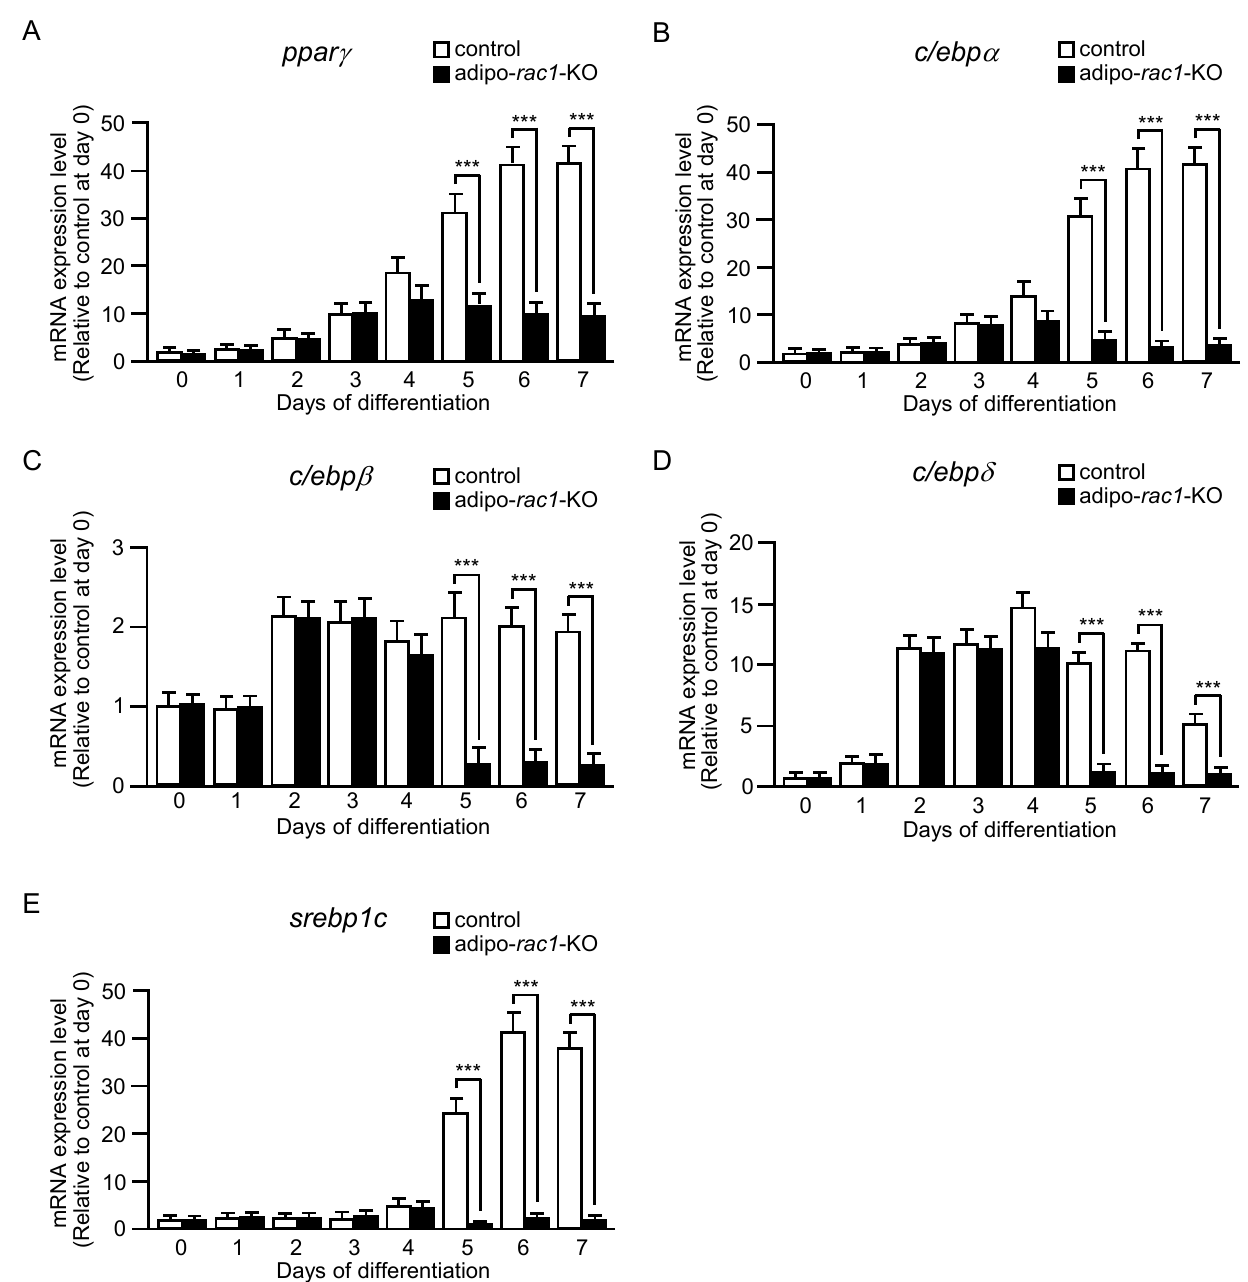
Figure 3. The expression of transcription factors during differentiation of adipose progenitor cells into adipocytes in vitro. The expression of ppar γ ( A ), c/ebp α ( B ), c/ebp β ( C ), c/ebp δ ( D ), srebp1c ( E ) genes during adipogenic differentiation in vitro. Relative mRNA levels in cells derived from control and adipo- rac1 -KO mice were determined by quantitative RT-PCR analysis. Data are shown as means ± S.E. ( n = 3). *** p < 0.001 (Student’s t